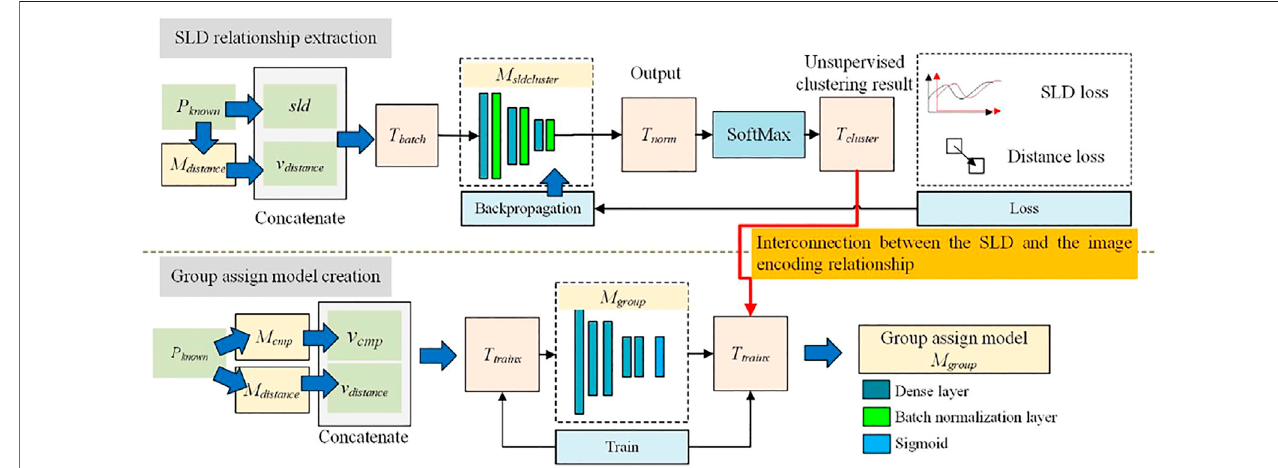
FIGURE 4 | Process of establishing the relationship between the SLD and the image encoding of a